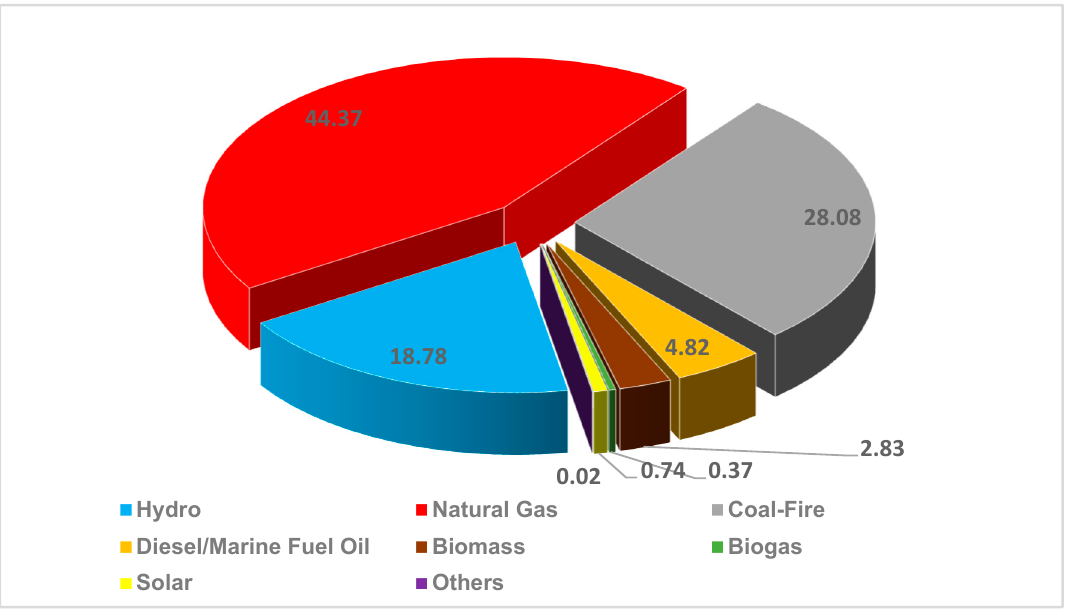
Figure 4. The percentage, %, of share in installed capacity of energy resources in the production of electricity [11].